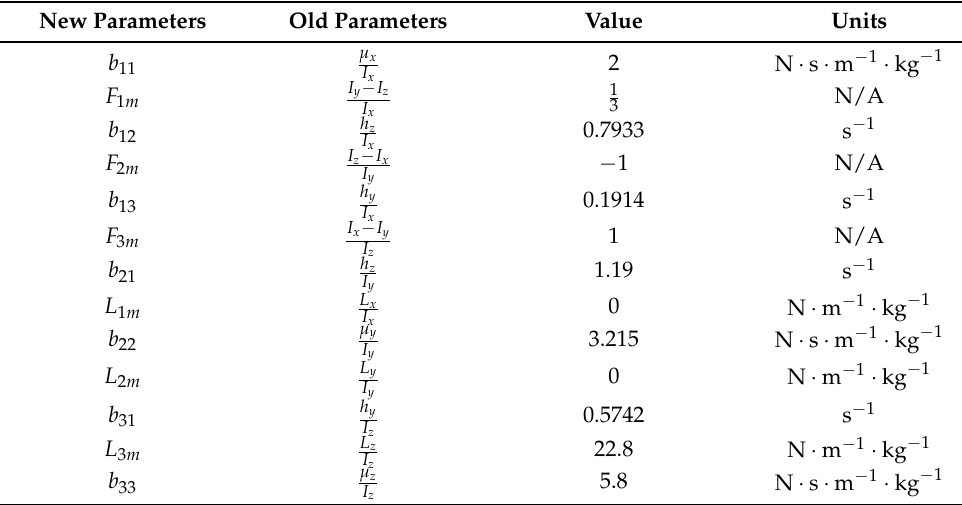
Table 1. Parametric values for Gyrostat chaotic model